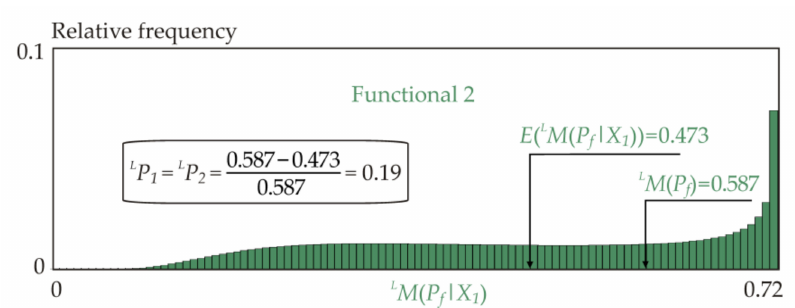
Figure 7. The functional 2-based sensitivity measure L M ( P f